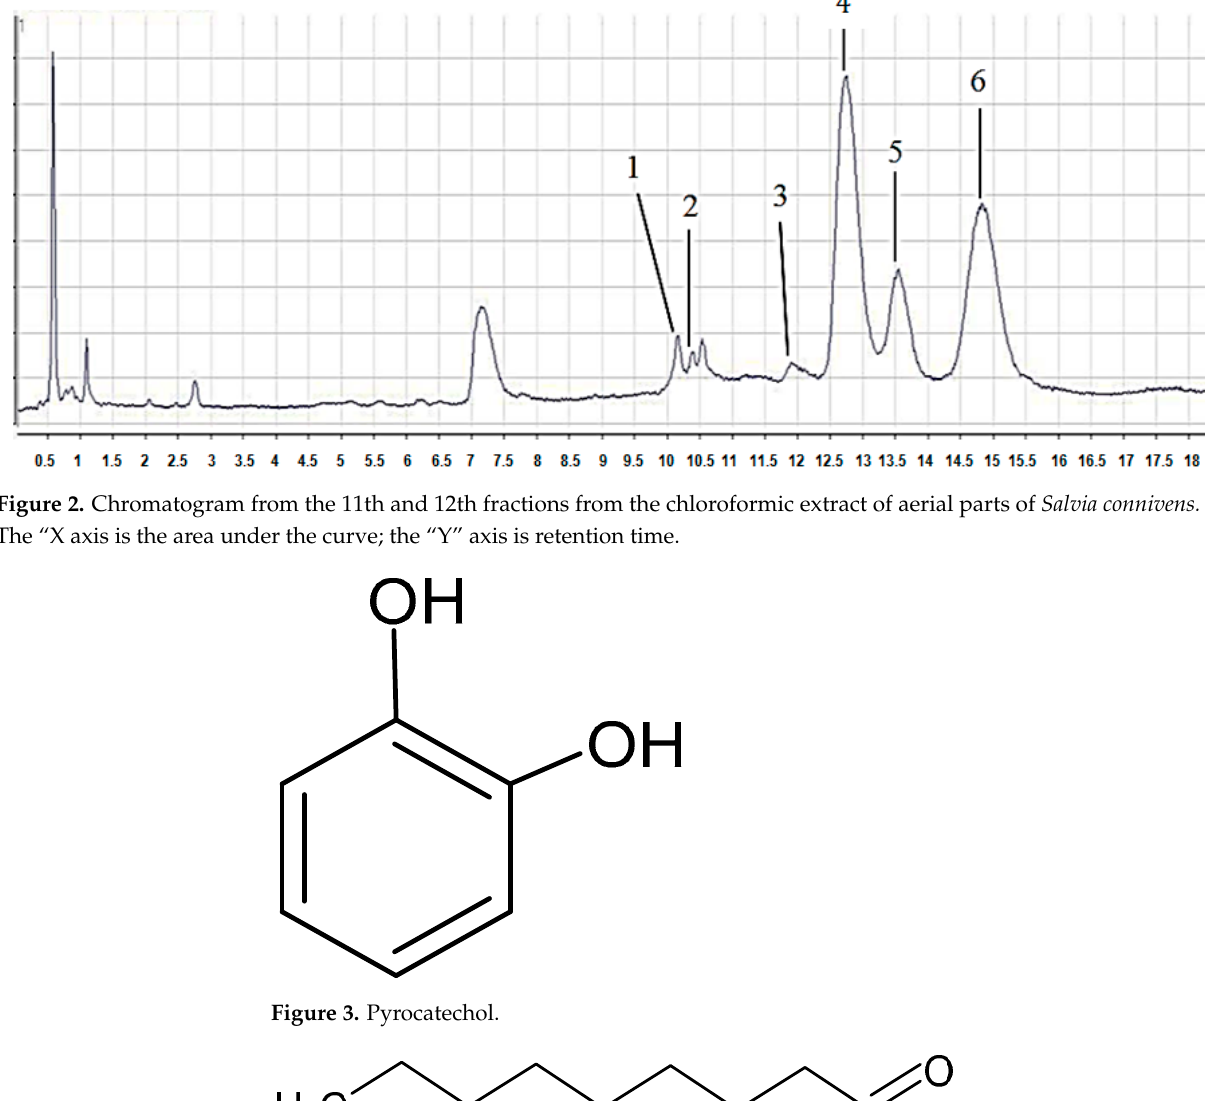
Figure 4. Nonanal. Figure 4.